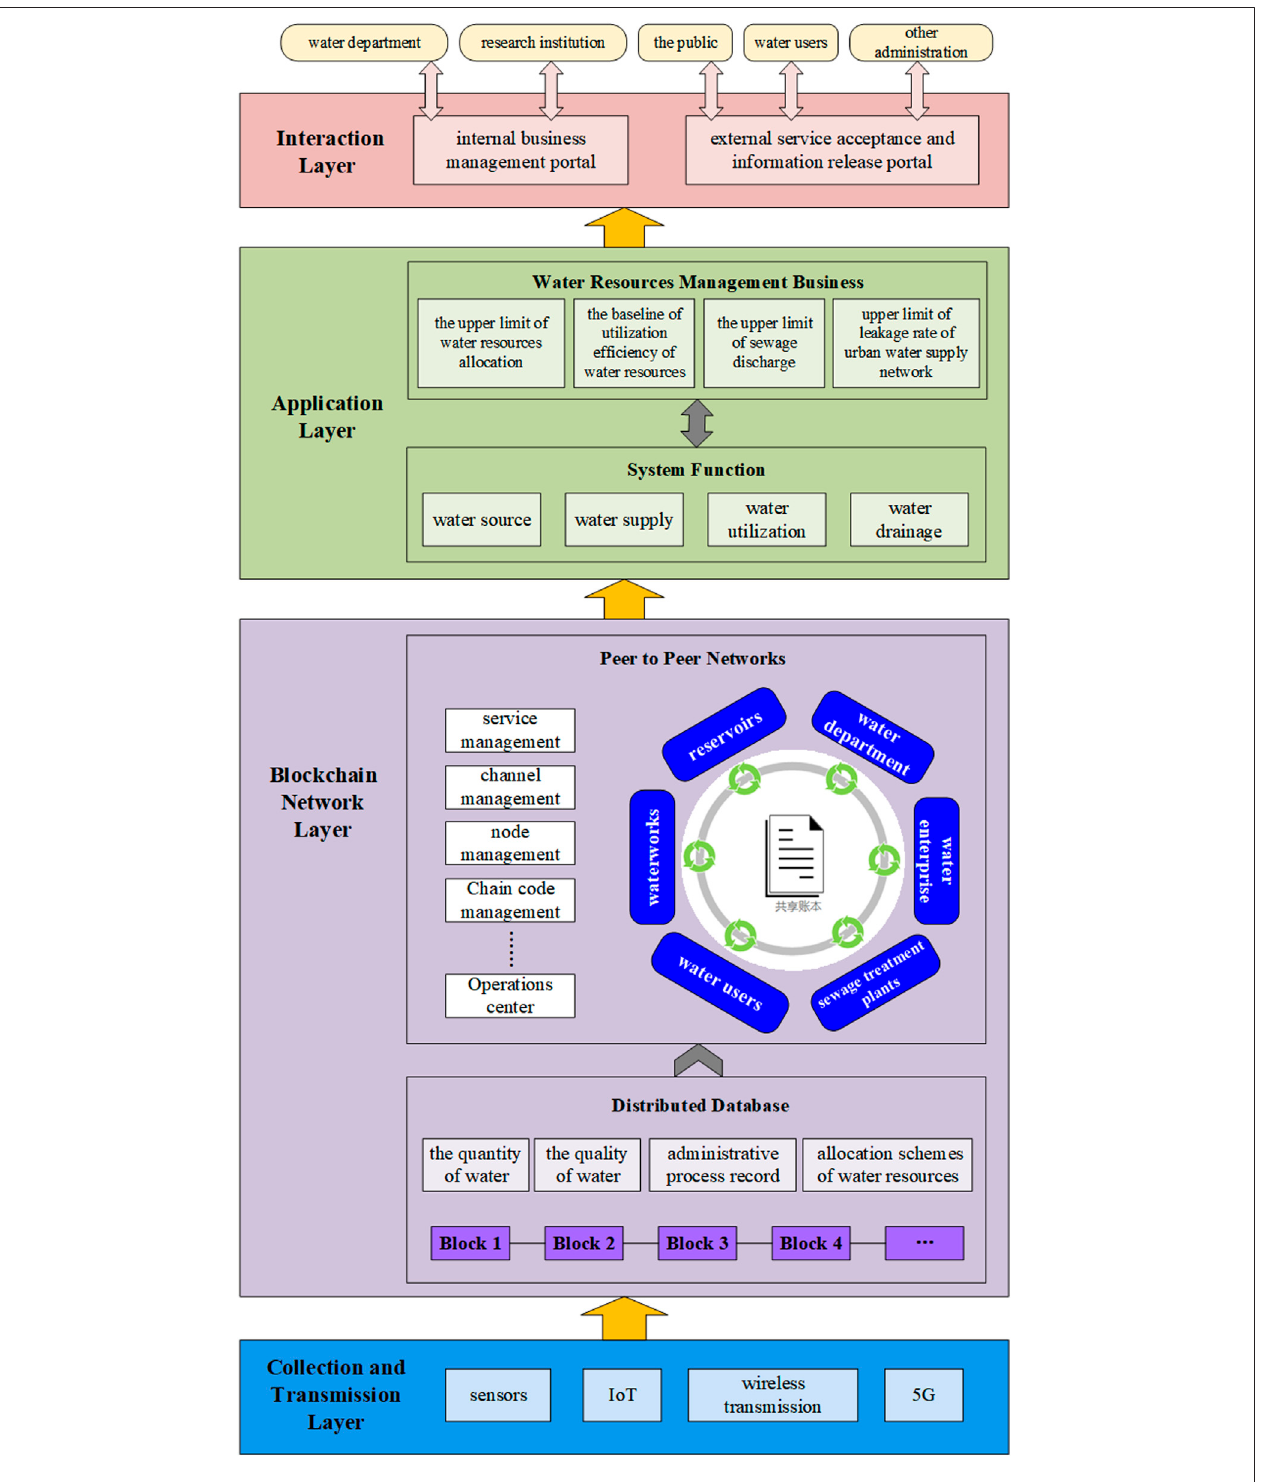
FIGURE 1 | The blockchain framework for water resource management